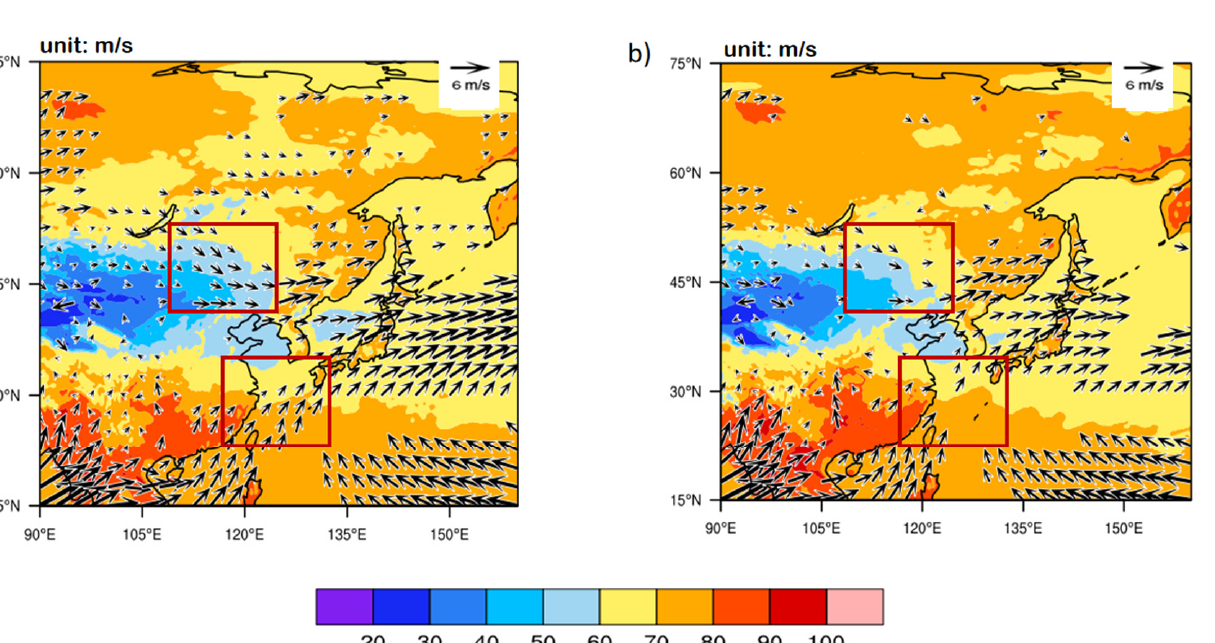
Figure 9. Pressure vertical velocity ( ω ) (10 − 5 Pa s − 1 , shaded) over Northeast China during MCVHR years (2016–2019) and LCVHR years (1979 and 1983–1985): ( a ) MCVHR years at 42° N, ( b ) LCVHR years at 42° N, ( c ) MCVHR years at 50° N, and ( d ) LCVHR years at 50° N. The red (blue) color indicates a positive (negative) significant anomaly. The dashed (solid) lines show ascending (de- scending) motion. Negative (positive) values indicate an upward (downward) motion.